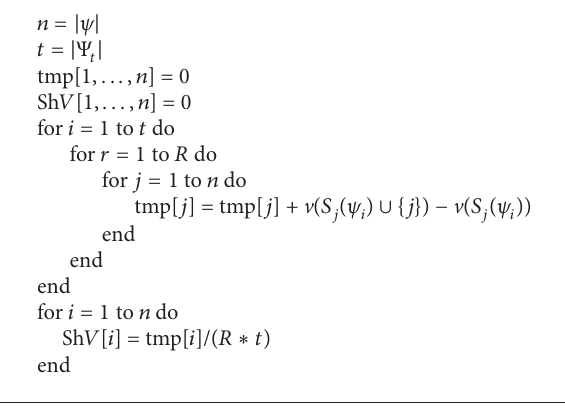
Table 1: The 𝑡 in the Ov and Sv algorithms for various